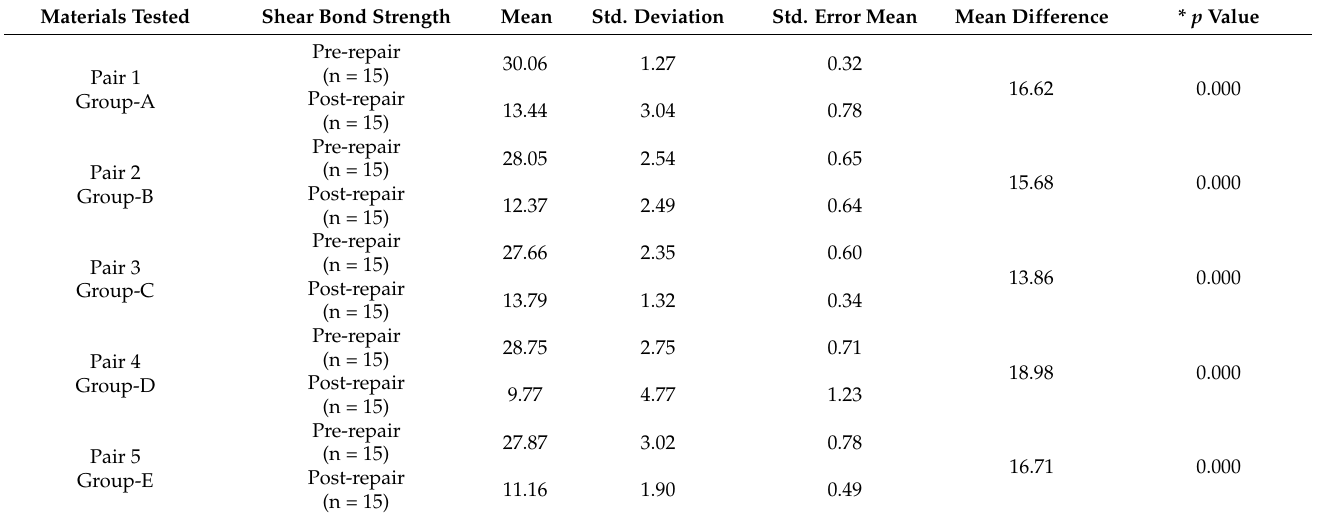
Table 4. Pairwise comparison of shear bond strength in megapascals (MPa) of test groups before and after the ceramic repair by Paired Samples T-test. Materials